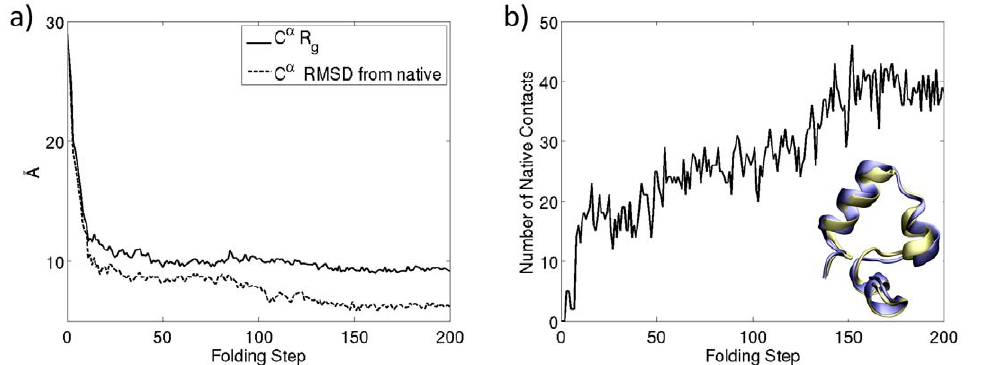
Figure 5. Evolution of radius of gyration, RMSD and contacts during folding. Evolution of radius of gyration R g , and RMSD of C a during folding are shown in panel (a). Evolution of number of contacts and comparison of the final MD structure with the native structure appear in panel (b).